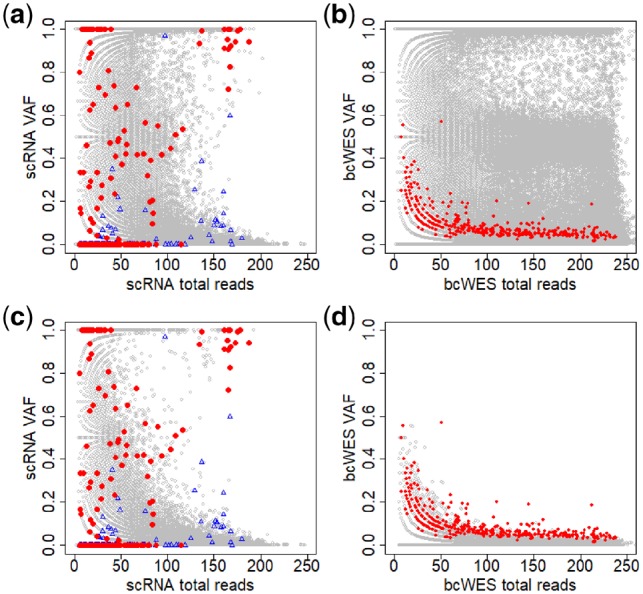
Noisy data create a great challenge in identifying mutations in single cells. (a and b) Plots of total reads versus VAFs across all SNVs for scRNA-seq and bcWES, respectively. Panels c and d are similar to Panels a and b after limiting by germline VAF=0. Gray circles are non-mutated SNVs and red dots are highlighted mutated sites detected from bcWES data. The blue triangles are highlighted mutated sites from non-tumor cells